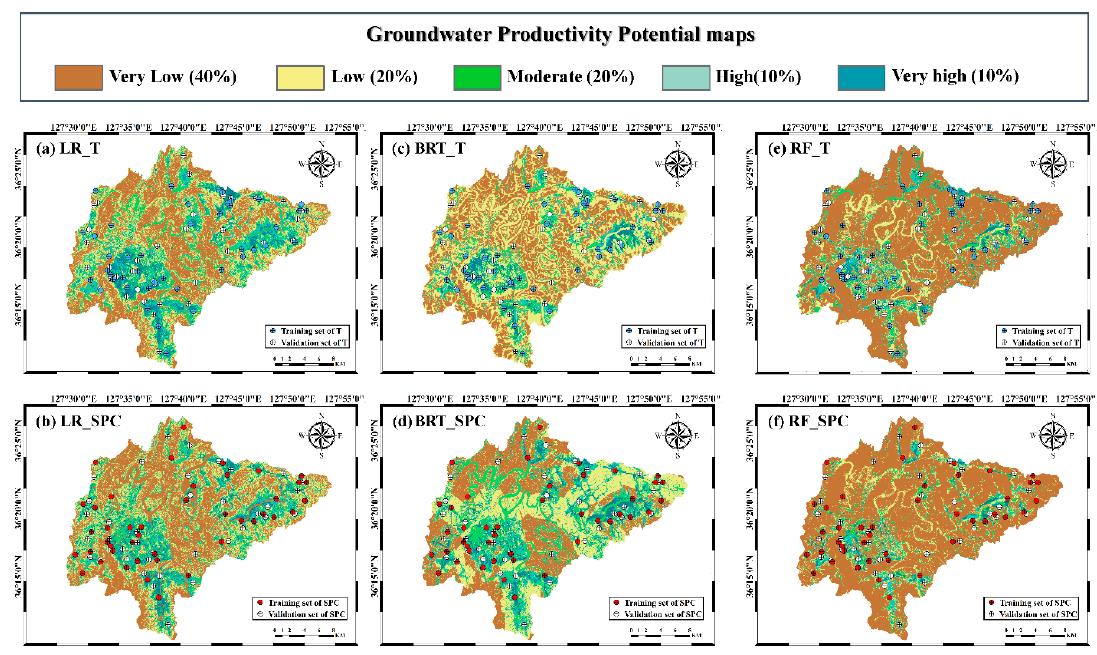
Figure 4. The results of GPP maps generated using LR, BRT and RF models. T/SPC values of ( a , b ) LR model, ( c , d ) BRT model and ( e , f ) RF model.